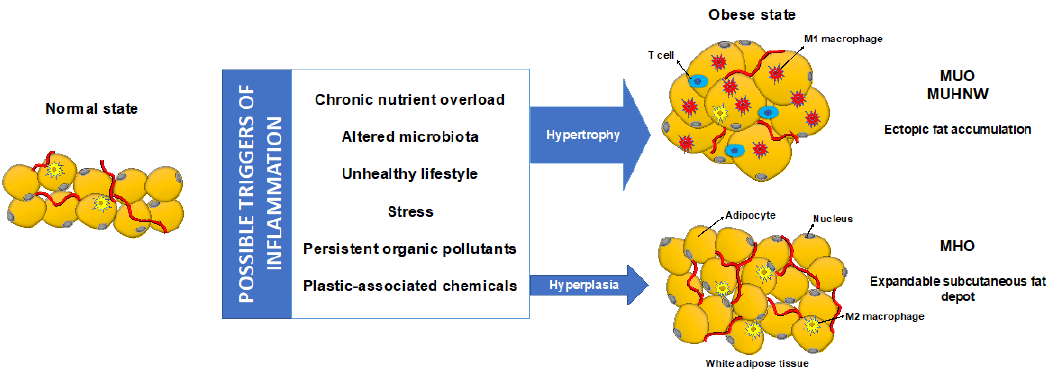
Figure 2. Interplay between factors contributing to inflammatory activation and adipose tissue dysfunction that may underlie the different obesity and metabolic phenotypes. Presence of the depicted possible triggers of inflammation may favor development of hypertrophic dysfunctional adipose tissue, with M1 macrophage recruitment, while impeding adipose tissue growth through hyperplasia with resident M2 macrophages, more prone to metabolic adaptation. M1, classically activated; M2, alternatively activated; MHO, metabolically healthy obese; MUHNW, metabolically unhealthy normal-weight; MUO, metabolically unhealthy obese.